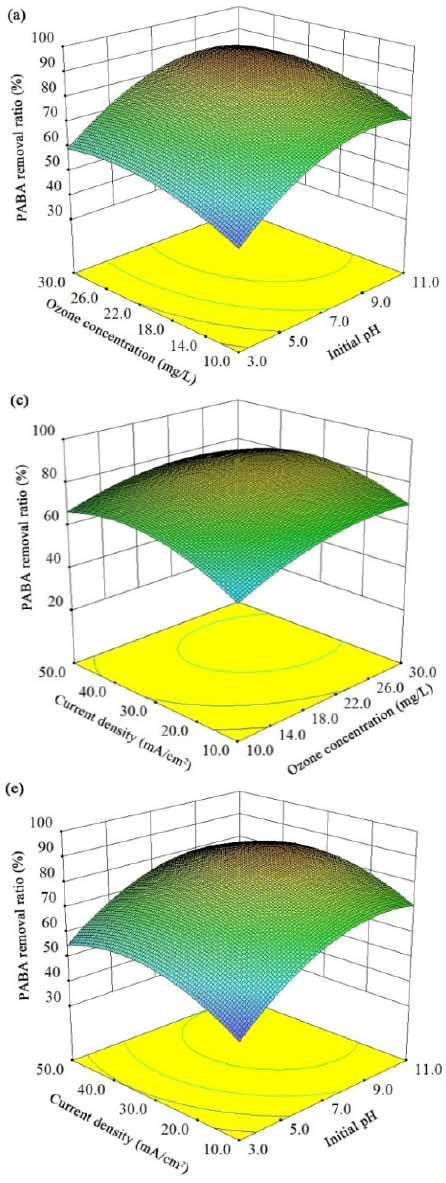
Figure 4. Response surface showing the PABA elimination efficiency as a function of two inde- pendent variables at 10-min treatment: ( a ) inlet gaseous ozone concentration and initial solution pH, ( b ) solution temperature and initial solution pH, ( c ) current density and inlet gaseous ozone concentration, ( d ) solution temperature and inlet gaseous ozone concentration, ( e ) current density and initial solution pH, ( f ) solution temperature and current density.